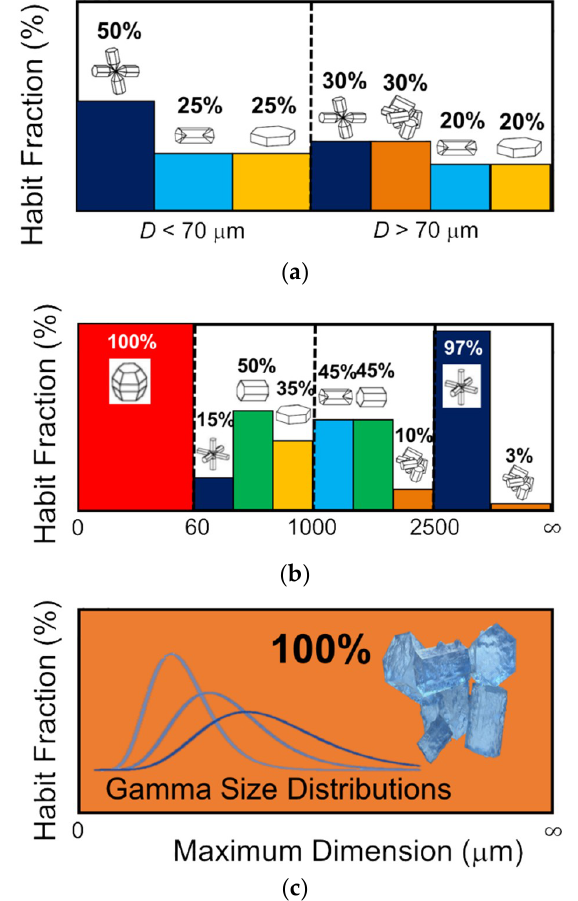
Figure 10. Ice cloud habit models used for: ( a ) MODIS Collection 4; ( b ) MODIS Collection 5; and ( c ) MODIS Collection 6 operational ice cloud property products.